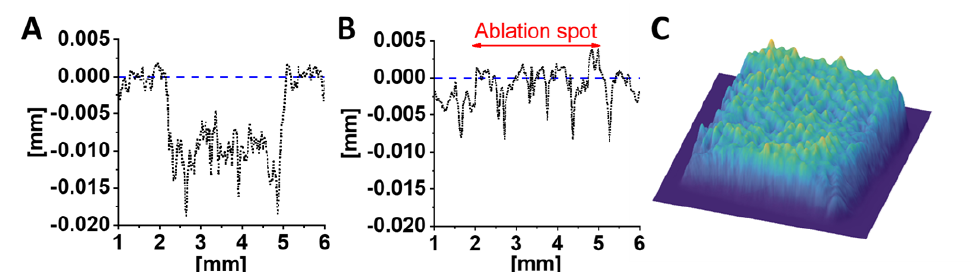
Figure 8. Profile of the ablation crater created in air by 10 shots of about 5 J, made by the Bivoj laser, on the chondritic meteorite Dho 1709 ( panel A ). Profile of the spot on the same chondritic meteorite Dho 1709, irradiated under a continuous flow of water, where no altitude differences were detected ( panel B ). Intensity profile of the Bivoj laser ( panel C ).